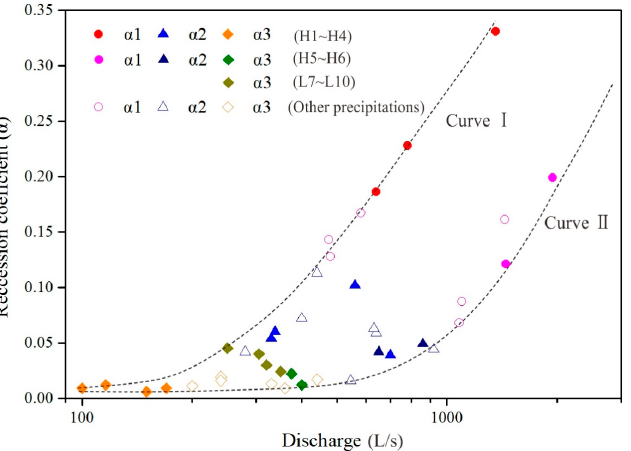
Figure 11. Relationship between recession coefficients and discharge flow rate at the beginning of each recession stage.